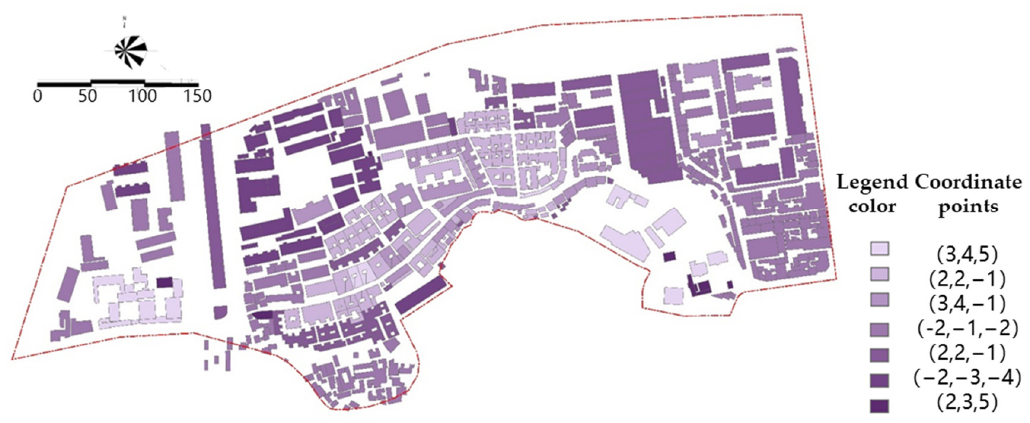
Figure 9. Building attributes clusters before renovation.